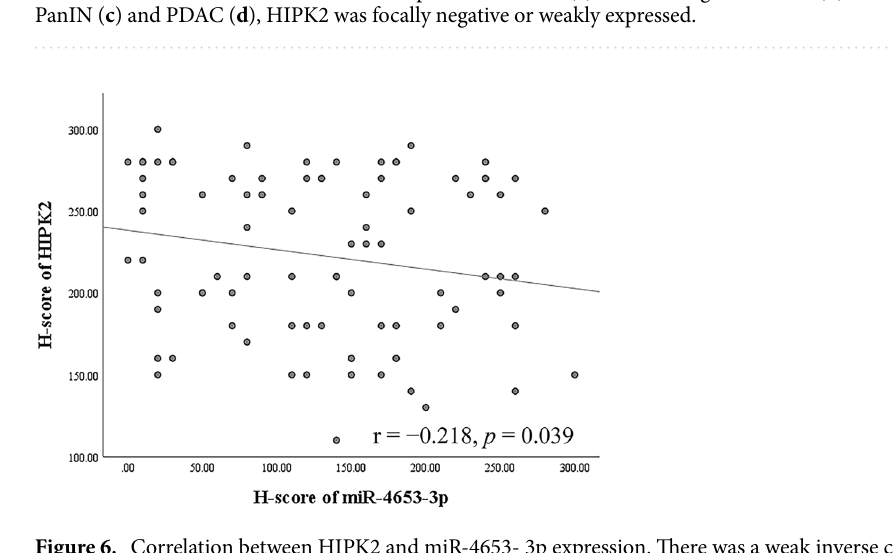
Figure 6. Correlation between HIPK2 and miR-4653- 3p expression. There was a weak inverse correlation between the H-score of immunohistochemistry of HIPK2 and the H-score of in situ hybridization of miR- 4653-3p in PDAC (r = − 0.218, p =